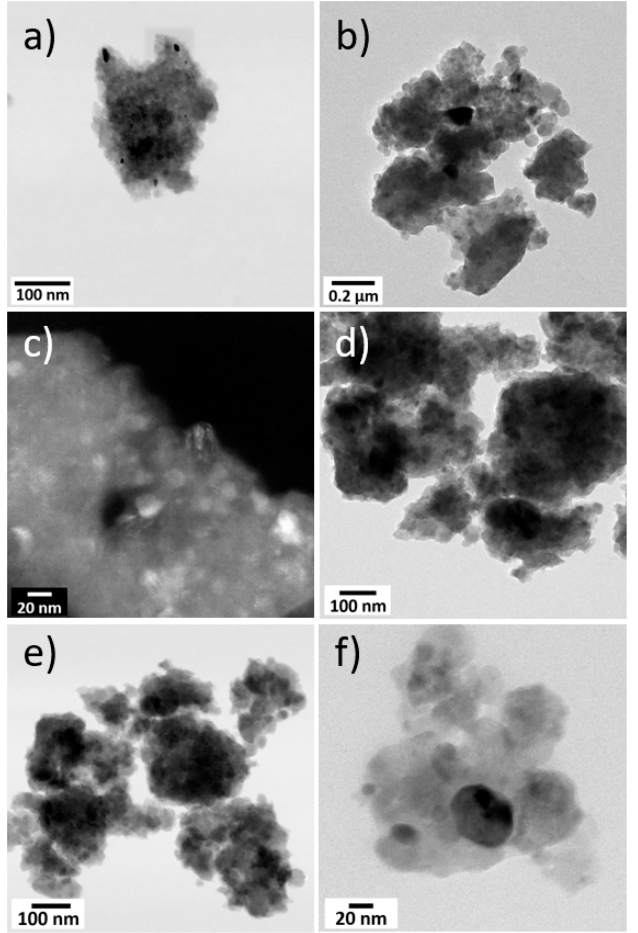
Figure 4. Brightfield and darkfield STEM images at different magnifications of the synthesized Mg 2 SiO 4 ( a – c ) and MgCoSiO 4 ( d – f